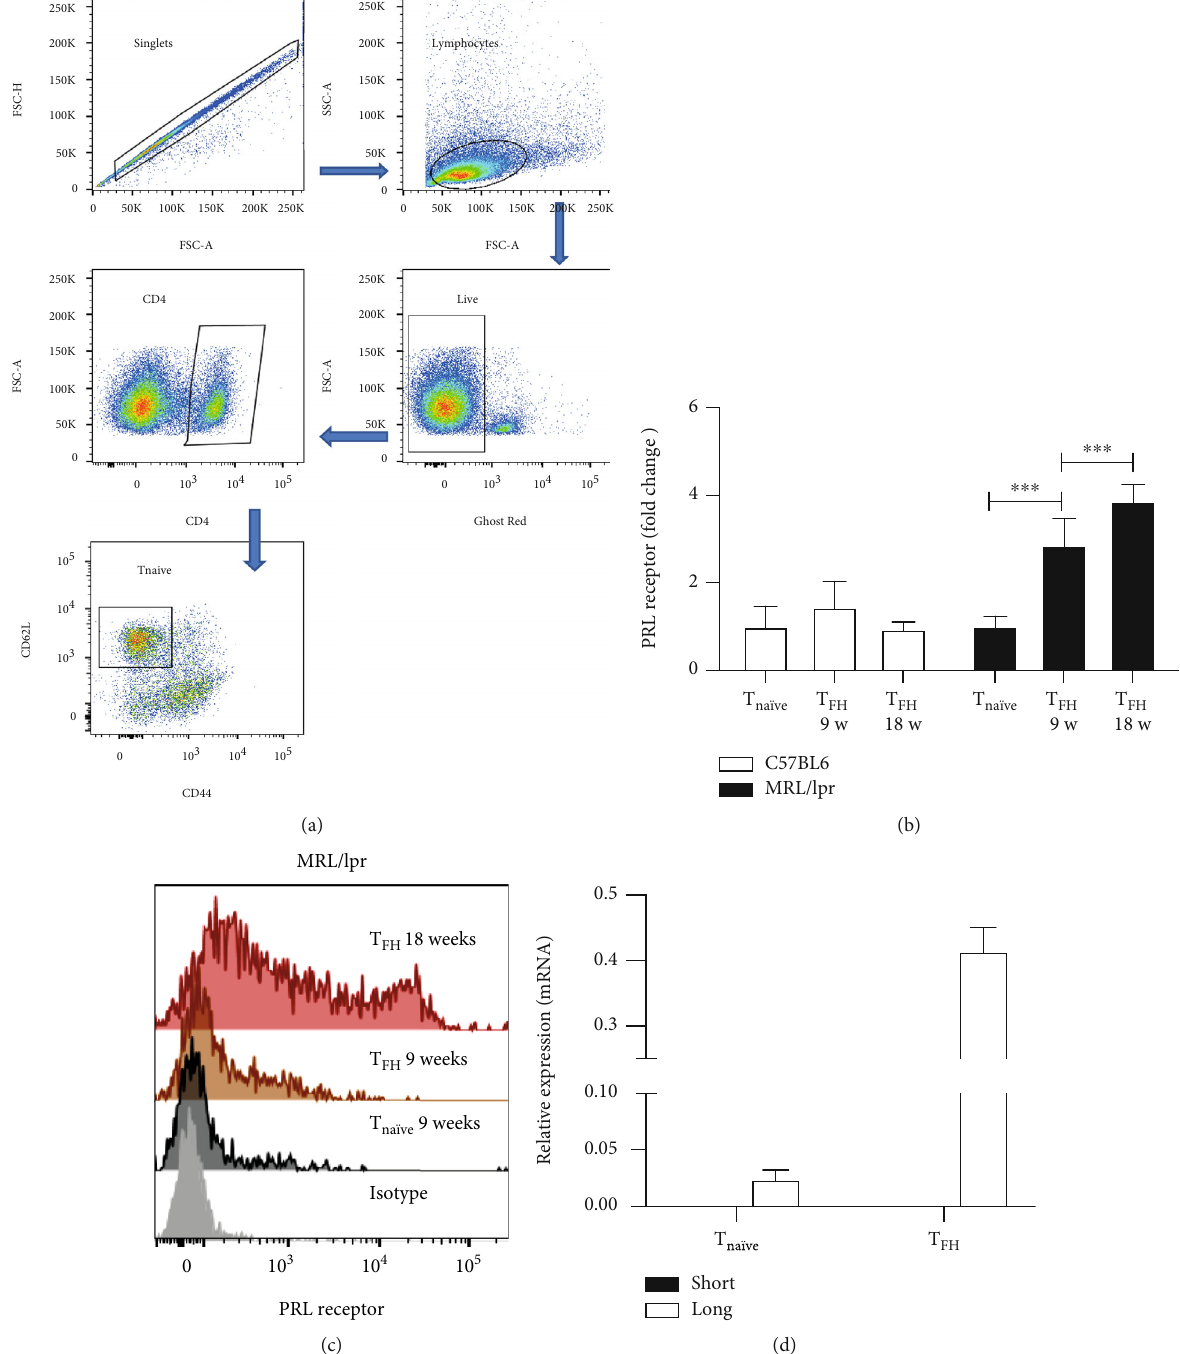
Figure 2: PRL receptor expression on T and T cells. Splenocytes from 9- and 18-week-old C57BL/6 and MRL/lpr mice were stained naïve FH cells (as shown in Figure 1(c)) and with anti-CD4, anti-CD44, and anti-CD62L for with anti-CD4, anti-CXCR5, and anti-PD1 for T FH T cells, then cells were stained with an anti-PRL receptor antibody. (a) Demonstration of the gating strategy for the fl ow cytometry naïve analysis of T cells. Doublets were excluded by gating on FSC-H × FSC-A, lymphocytes were identi fi ed on the basis of their scatter naïve properties (FSC-A × SSC-A plot), and live cells were gated in the Ghost Red − . The gate of CD4 + T was selected (CD62L + CD44 − ). (b) naïve Expression of the PRL receptor is reported as the fold change in receptor expression with respect to PRL receptor expression in T naïve cells. (c) Representative histogram of PRL receptor expression in MRL/lpr mouse cells. The measurement was carried out in duplicate in six mice per group. Pooled data are presented as the mean ± SD ; ∗∗∗ p < 0 : 001 using ANOVA. (d) T and T cells from 18-week-old naïve FH MRL/lpr mice were puri fi ed by Sort, and the isoform of the PRL receptor was determined by real-time (RT-) PCR. The murine breast cancer cell line EpH4 1424 was used as a positive control for the expression of the long and short PRL receptor isoforms (not shown). Two di ff erent experiments were performed; in each experiment, a pool of cells isolated from three mice was